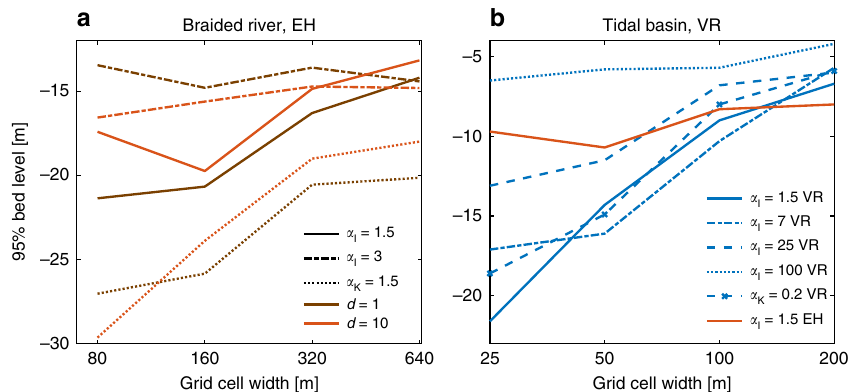
Fig. 5 Grid size-dependent incision. Tendency to incise quanti fi ed as 95% depth against size of the grid cells for different magnitudes of slope effect, of a the braided river model in combination with the sediment transport predictor of Engelund – Hansen, and a horizontal eddy diffusivity d of 1 or 10, and b the tidal basin model